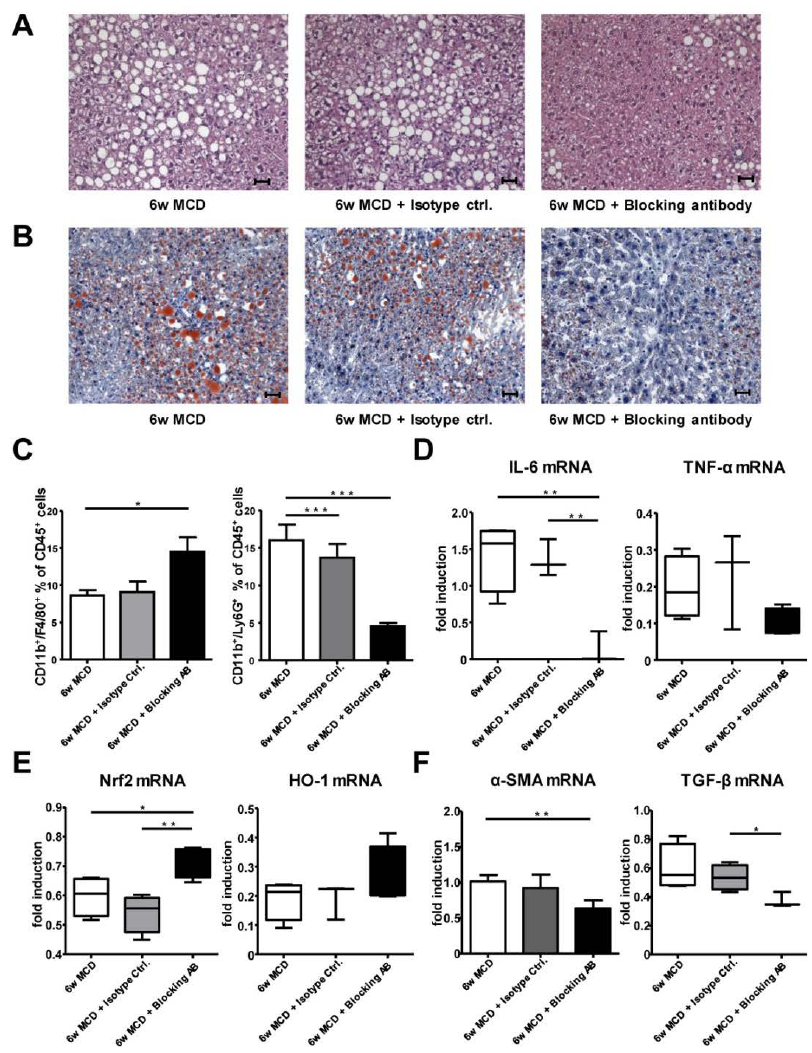
Figure 6. Therapeutic intervention with a CD62L blocking antibody results in dampened pro-inflammatory changes and stronger anti-oxidative stress responses in liver. ( A ) Representative H&E images or ( B ) Oil Red O stains of livers from WT mice after 6 w MCD with or without peritoneal administration of an isotype control antibody or a CD62L blocking antibody from week 4–6 after MCD feeding (400×, scale bars 50 µm). ( C ) Intrahepatic CD11b + /F4/80 + cells were analysed by FACS after 6 w MCD with or without peritoneal administration of an isotype control antibody or a CD62L blocking antibody from week 4–6 after MCD feeding. Cells were gated by FSC/SSC; duplets were excluded. Live/CD45+, then gated on CD11b + and F4/80 + (* p < 0.05). Intrahepatic neutrophils were analysed by FACS in the same groups. Cells were gated by FSC/SSC; duplets were excluded. Live/CD45 + , CD11b + /Ly6G + were regarded as neutrophils (*** p < 0.001). ( D ) Hepatic IL-6 and TNF- α, (E) Nrf and HO- 1, (F) α -SMA and TGF- β mRNA expression was analysed in the same groups via RT-qPCR. Values are expressed as fold induction over the mean values obtained for WT mice treated with MCD diet for 6 weeks (* p < 0.05**, p < 0.01). All data are expressed as mean ± SEM ( n = 4). All experiments were repeated at least twice.